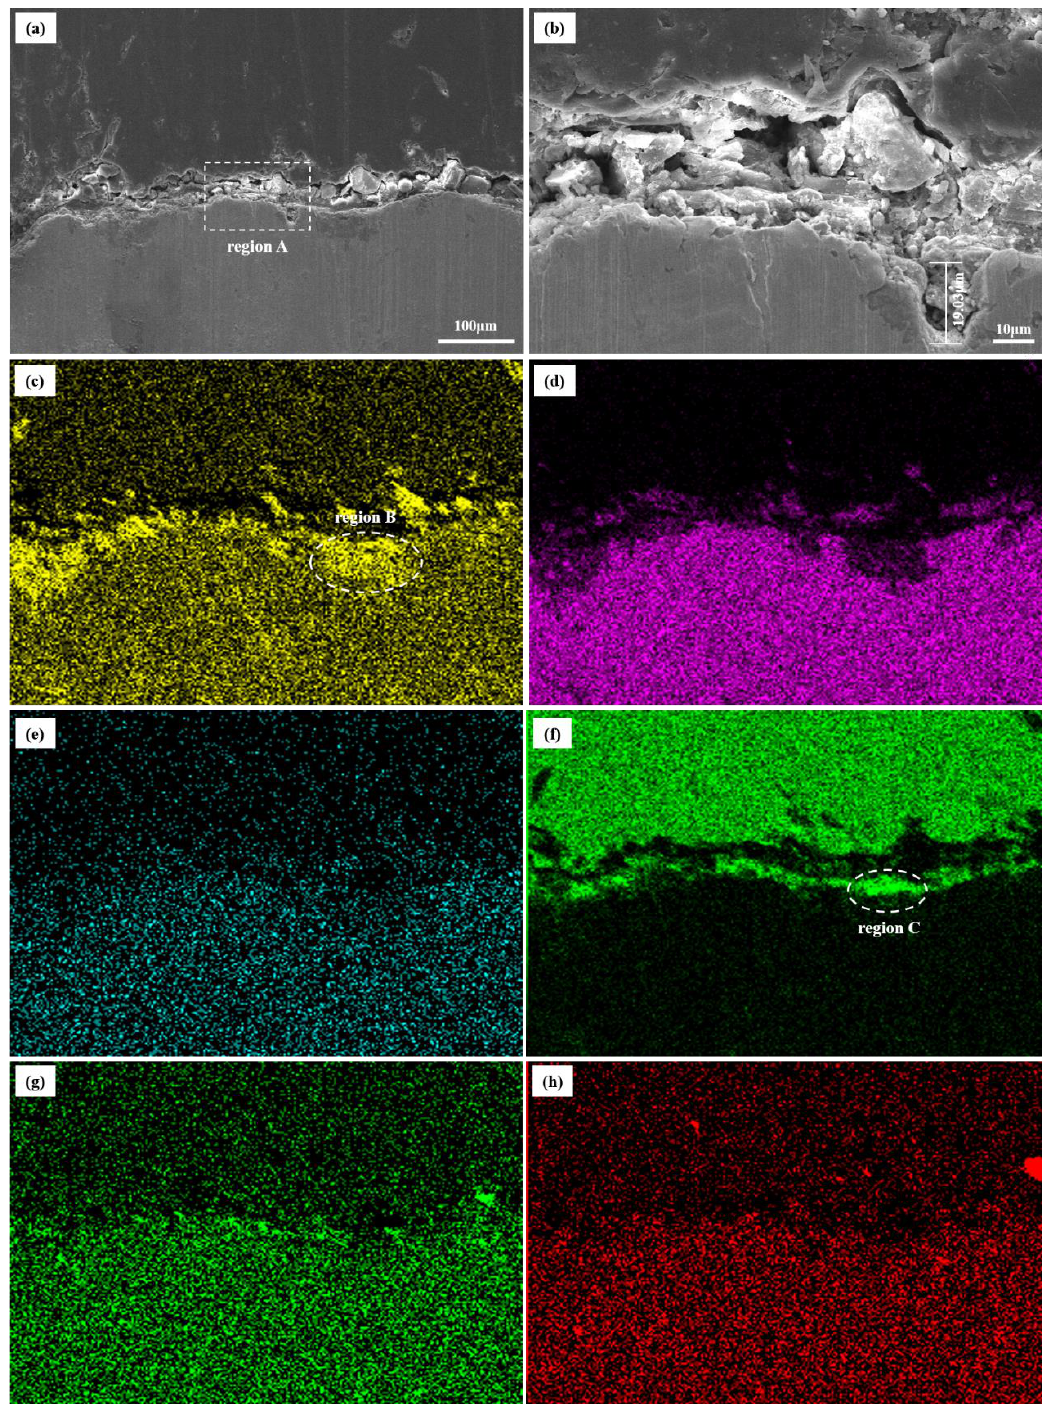
Figure 10. SEM/EDS images of corrosion scales on inner wall. ( a , b ): Cross-section SEM surface morphologies; ( c ): oxygen; ( d ): ferrum; ( e ): barium; ( f ): carbon; ( g ): sulfur; ( h ): strontium.